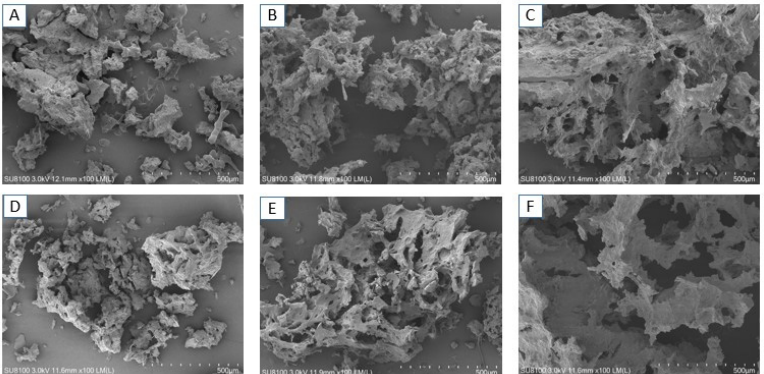
Figure 6. Scanning electron microscope diagram of casein under different pressure conditions. ( A ): 0 MPa (control); ( B ): 100 MPa; ( C ): 150 MPa; ( D ): 200 MPa; ( E ): 250 MPa; ( F ): 300 MPa; The magnification of scanning electron microscope was 100 times.